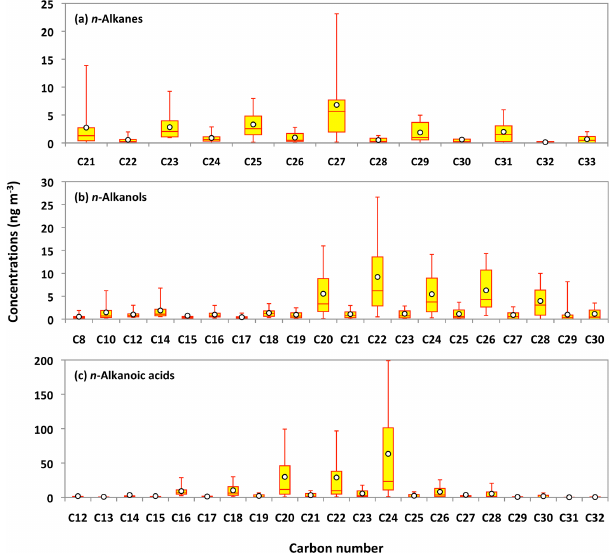
Figure 7. Molecular distributions of lipid compounds in PM 2 . 5 aerosols collected in central Alaska. See Fig. 5 for the description of the box-and-whisker